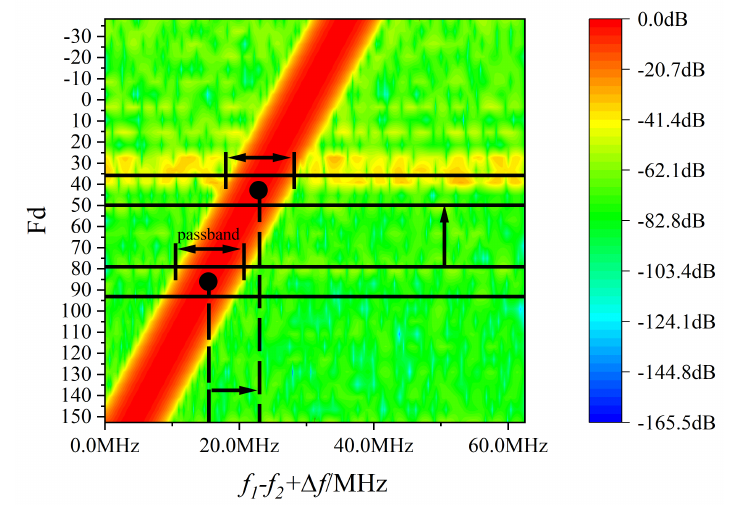
Figure 11. Frequency response of the variable coefficient